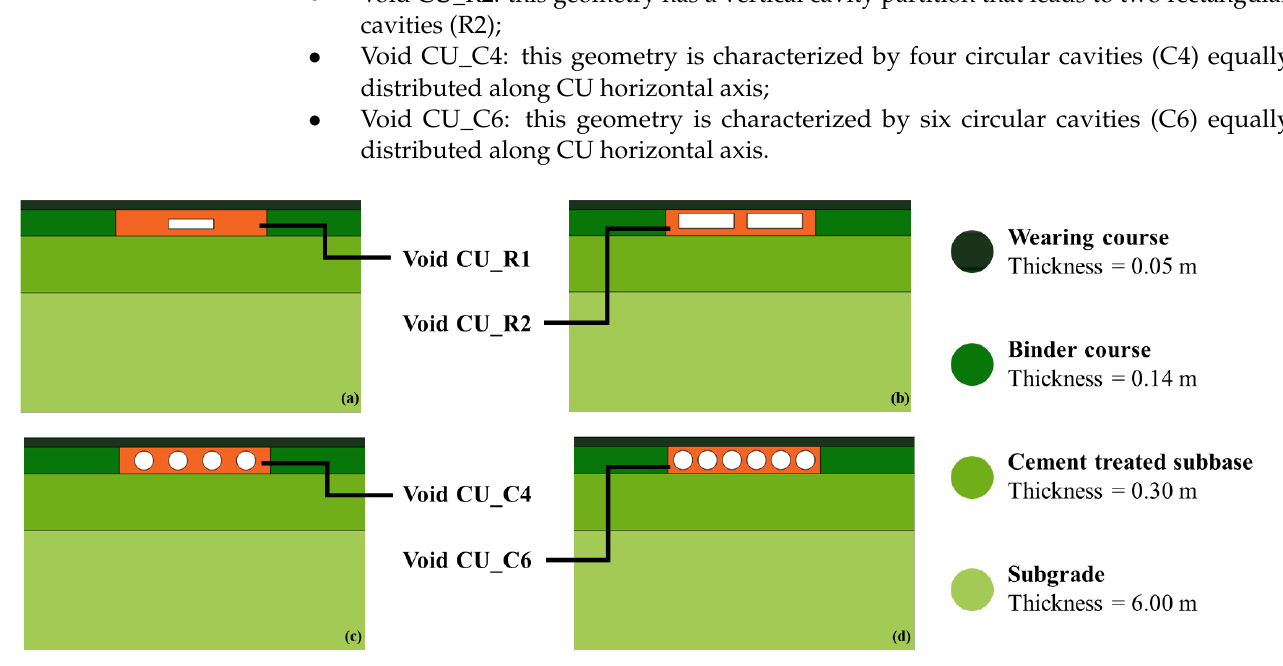
Table 1. Concrete main characteristics.